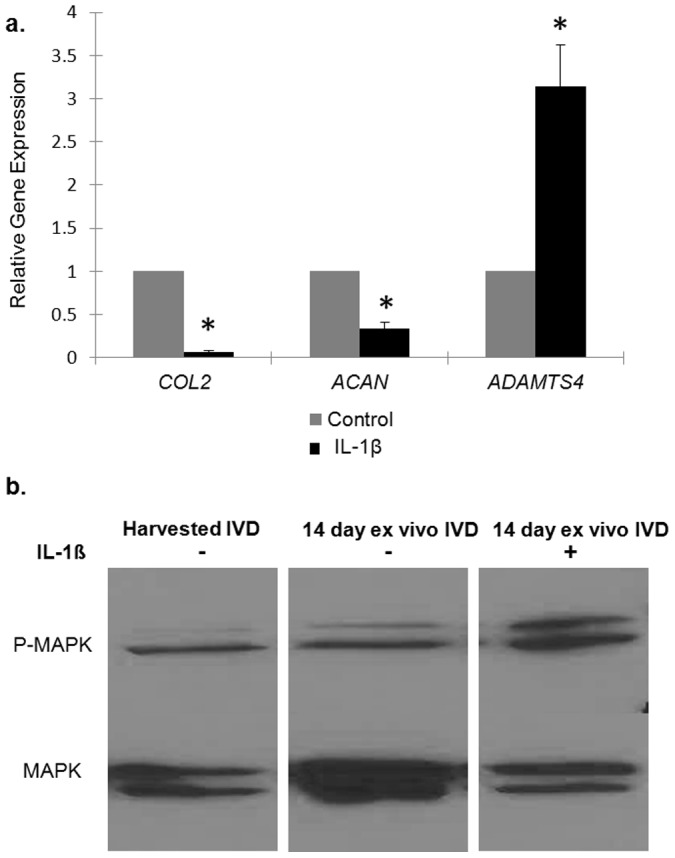
IVD explant response to IL-1ß.(a) When treated with IL-1ß at 10 ng/mL for 12 hours, IVD explants demonstrate significant decreases in gene expression of COL2 (p = 7.4×10−11) and ACAN (p = 3.0×10−5); ADAMTS4 (p = 0.009) gene expression is increased. Values are normalized to GAPDH. Results are presented relative to IVDs cultured without IL-1ß where the expression value was set to 1 (b) Murine IVD explants demonstrate increased MAPK phosphorylation when treated with IL-1ß at 10 ng/mL for 24 hours. * denotes statistical significance (p<0.05).